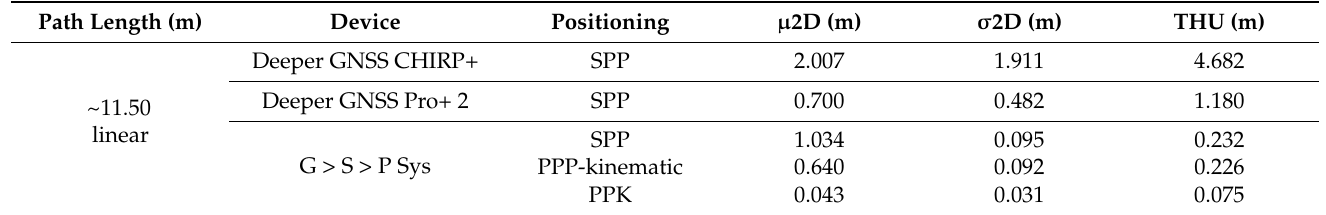
Table 11. Performance in the GNSS kinematic planimetric positioning of the Deeper Smart Sonar Table 12. Performance in the GNSS kinematic positioning of the G > S > P Sys in the pool test.